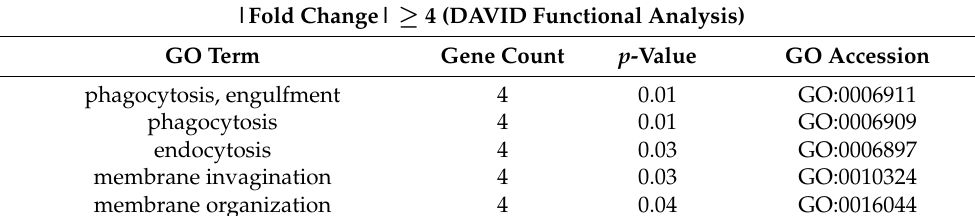
Table 3. Biological process groups identified by the functional annotation clustering analysis with |fold change| ≥ 4 and 2 (DAVID functional